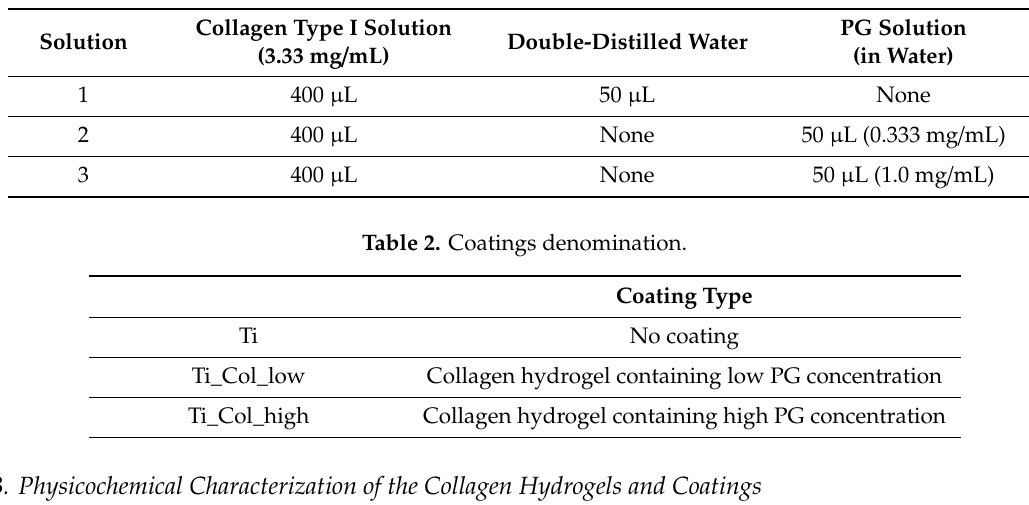
Table 1. Collagen hydrogels composition.